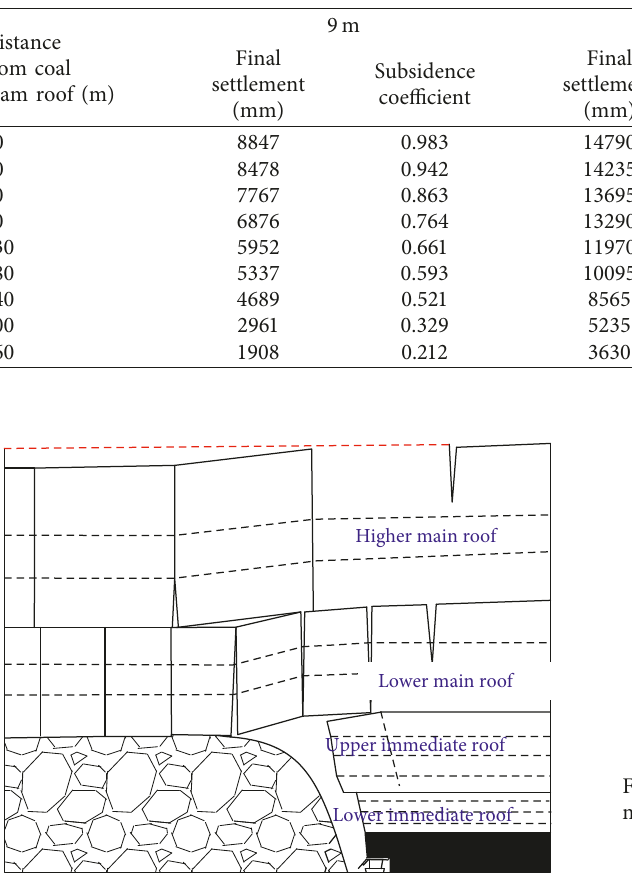
Table 4: Overlying strata convergence in different thick coal seams.